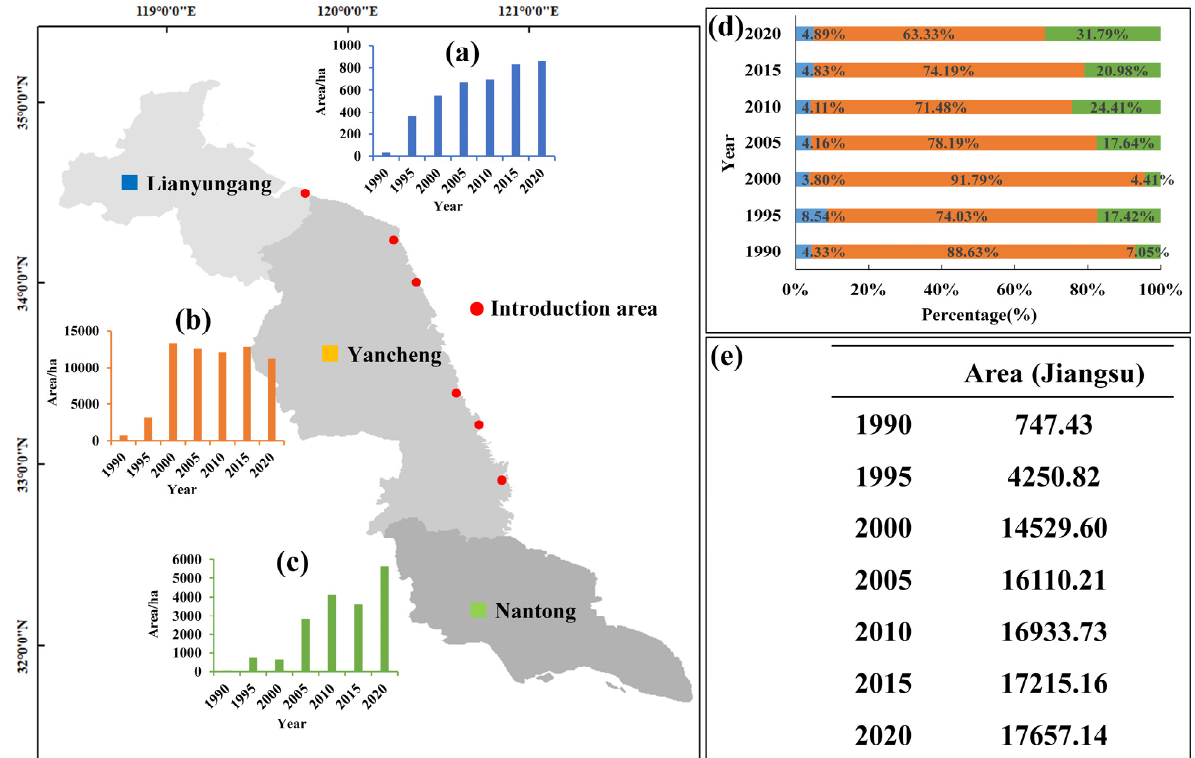
Figure 10. Statistical data of S. alterniflora area (ha) in Jiangsu Province from 1990 to 2020. The red mark is the introduction zone of S. alterniflora in Yancheng. ( a – c ) Statistics on the area of S. alterniflora in three coastal cities. ( d ) The distribution proportion (%) of S. alterniflora in three coastal cities from 1990 to 2020. ( e ) Statistical table of the area of S. alterniflora in Jiangsu Province.